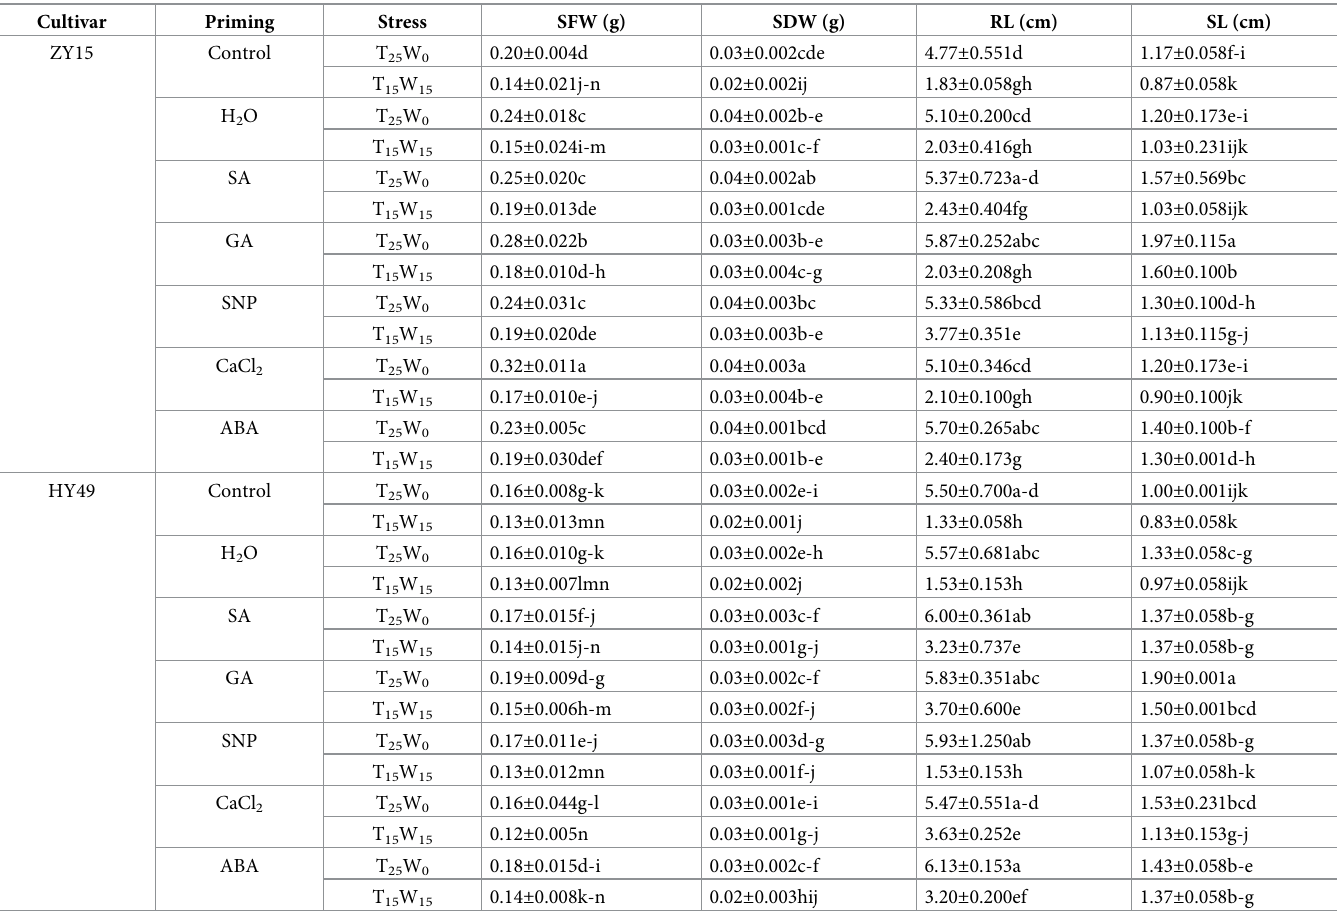
Table 2. Effects of different seed priming strategies on plant biomass under low temperature and drought conditions.